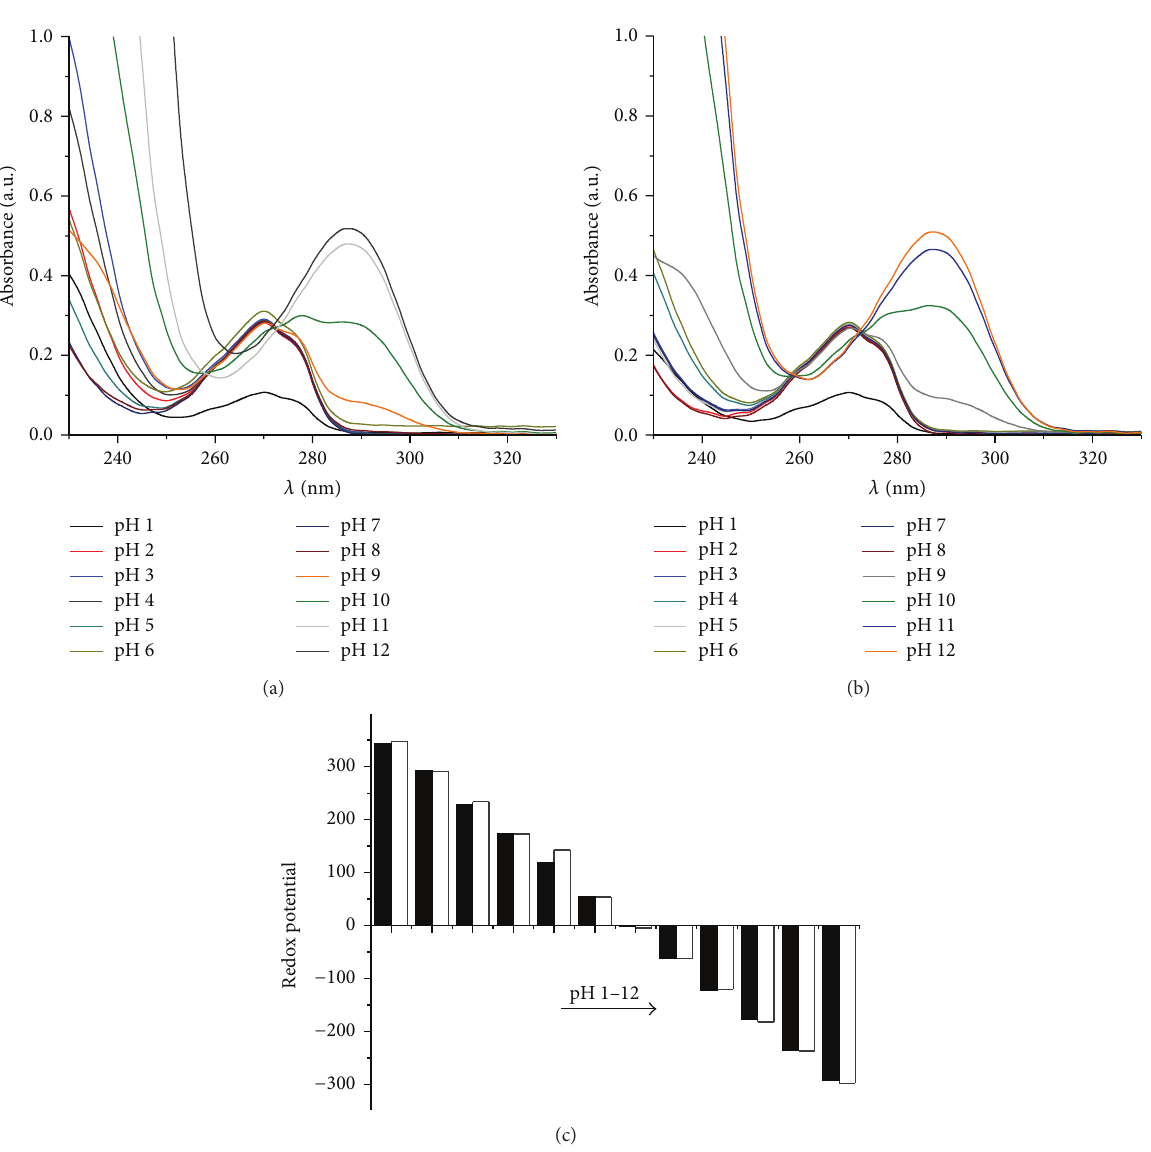
Figure 5: UV-Vis analysis of the pH effect on the chemical state of phenol, using 30 mgL −1 of TOC in (a) 0.05 M NaOH/H 2 SO 4 (pH 12–1), (b) 0.05 M NaOH/HCl (pH 12–1), and (c) ORP analysis under the same conditions to 298